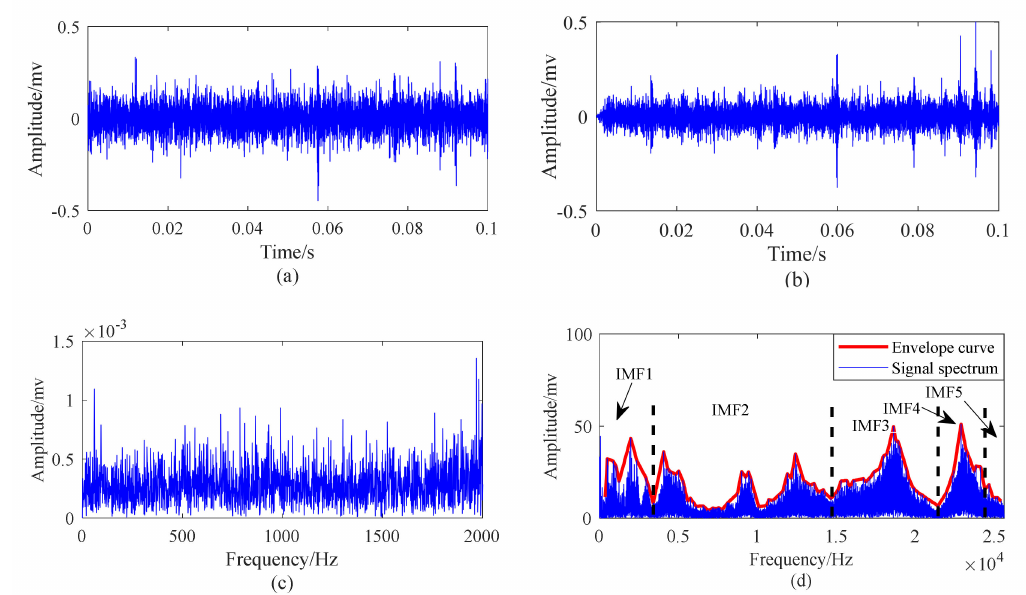
Figure 26. The collected signal of the bearing with 3 mm outer race fault and the result of the collected signal processed by the MCKD-EWT method: ( a ) the original signal; ( b ) the de-noised signal processed by MCKD method; ( c ) the spectrum of the original signal; ( d ) the Fourier spectrum segmentation result of the de-noised signal obtained by Improved EWT method.